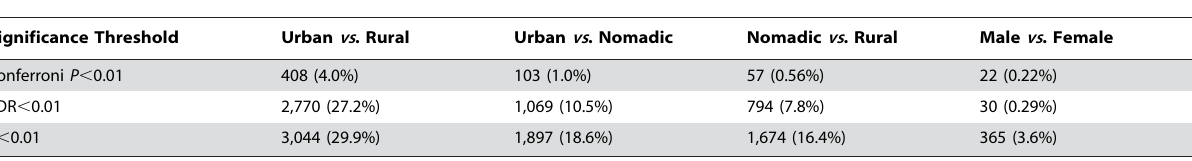
Table 1. Number of differentially expressed genes.